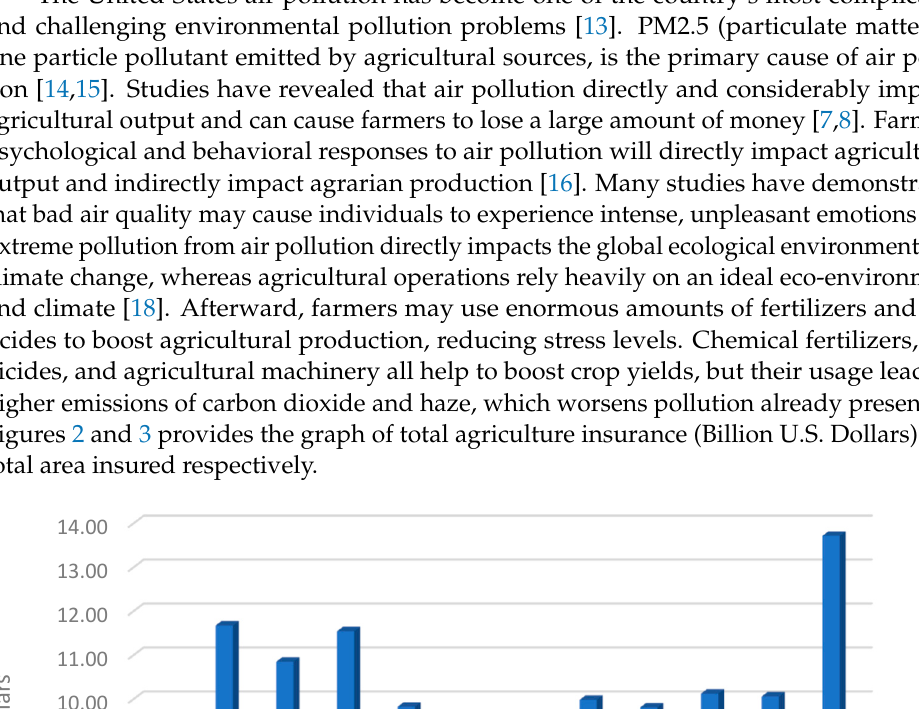
Figure 1. The study area map (source: Google Maps).